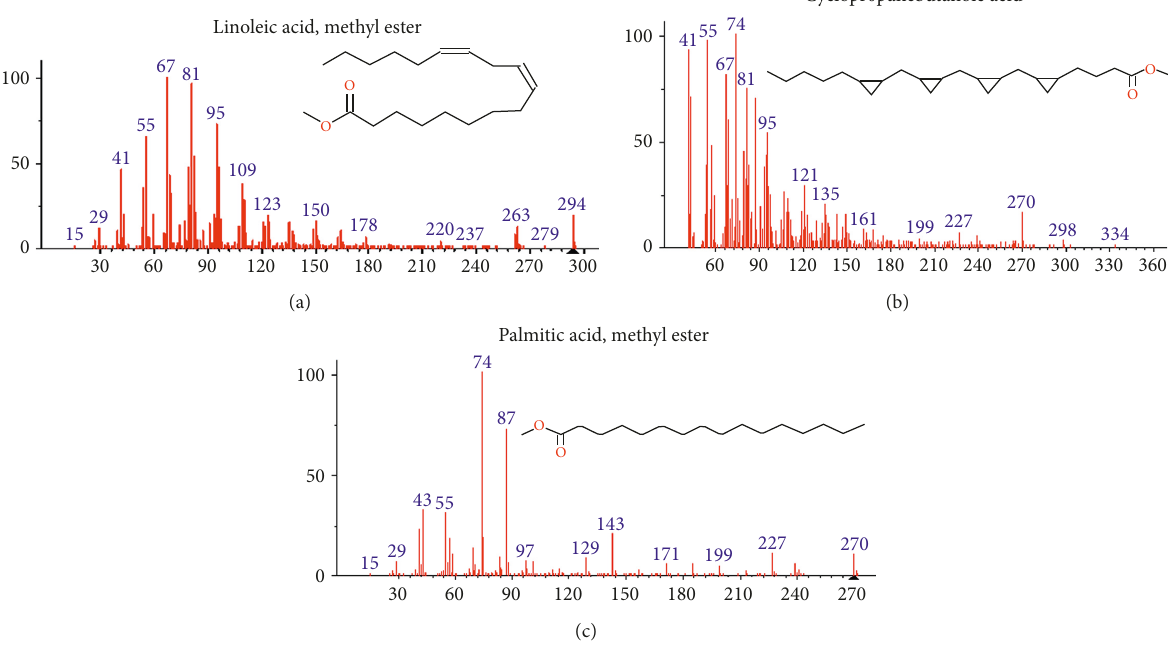
Figure 5: Chemical structure and EIMS fragmentation pattern of (a) CSP � C. scolymus L. petal, (b) CSC � C. scolymus L. choke, and (c) CSH � C. scolymus L. heart.